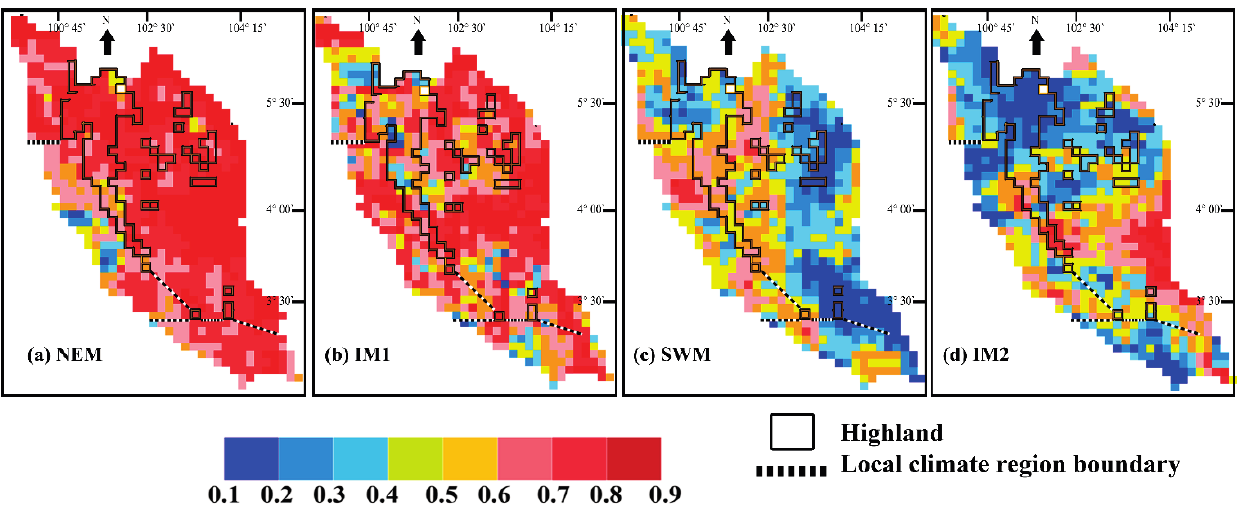
Figure 5. Temporal maps of seasonal correlation of the TRMM 3B43 against ground rainfall. ( a ) NEM: Northeast monsoon, ( b ) IM1: Inter-monsoon 1, ( c ) SWM: Southwest monsoon, ( d ) IM2: Inter-monsoon 2.